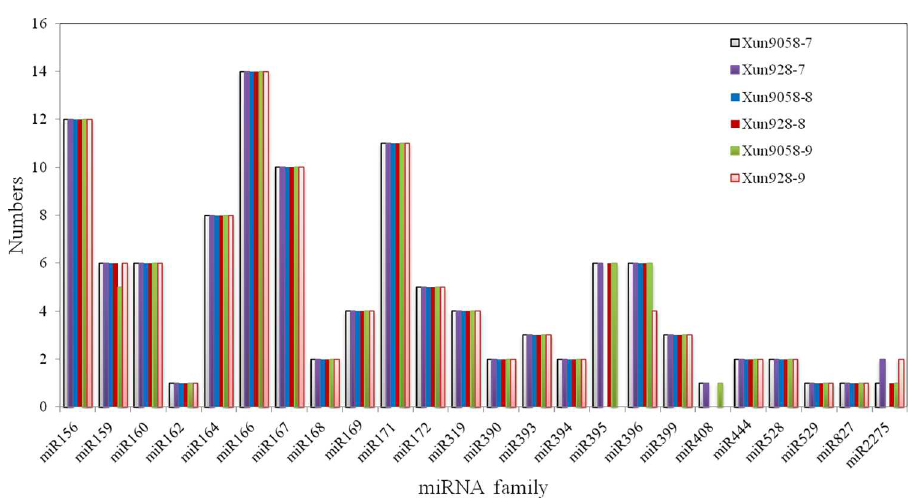
Fig 2. Conserved miRNA family members in the six maize internode libraries. miR166 consisted of 14 members, miR156 and miR167 had 12 and 10 members, respectively, and miR162, miR529, miR827 and miR1432had only one